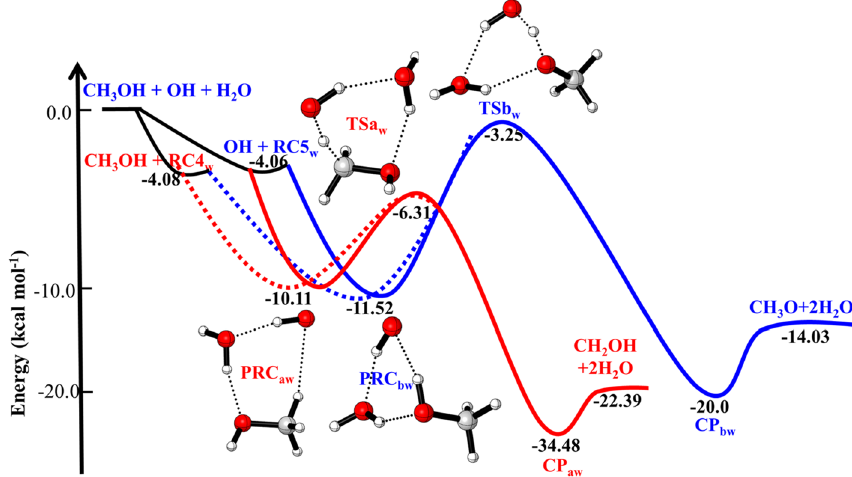
Figure 5. Potential energy surface for water assisted OH + CH 3 OH reaction obtained using CC//M06-2X with 6-311++G(3df,3pd) basis set. The relative energies include zero-point corrections.